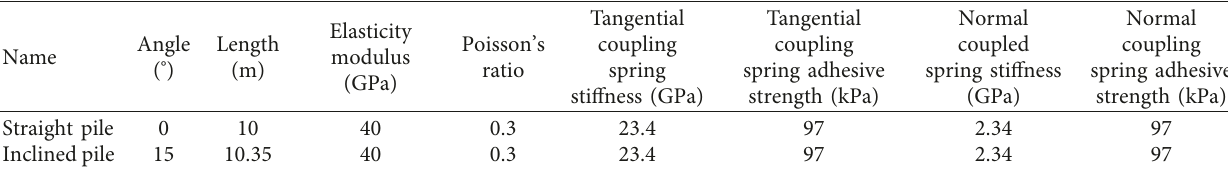
Figure 4: Model of the dynamic calculation. Table 3: Parameters of piles.